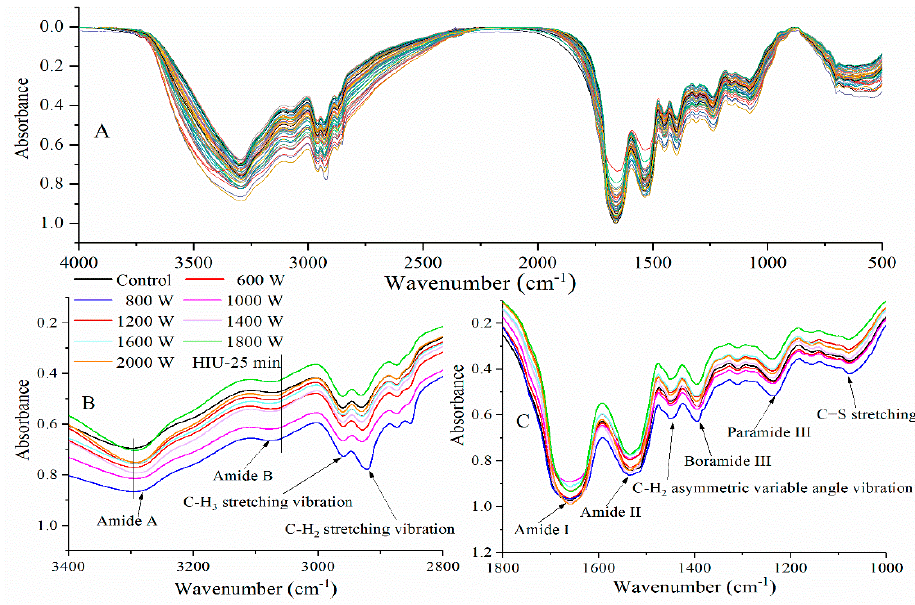
Figure 2. FTIR spectra of SPI after HIU treatment ( A : 4000–500 cm − 1 ) and HIU treated 25 min ( B : 3400–2800 cm − 1 , C : 1800–1000 cm − 1 ).